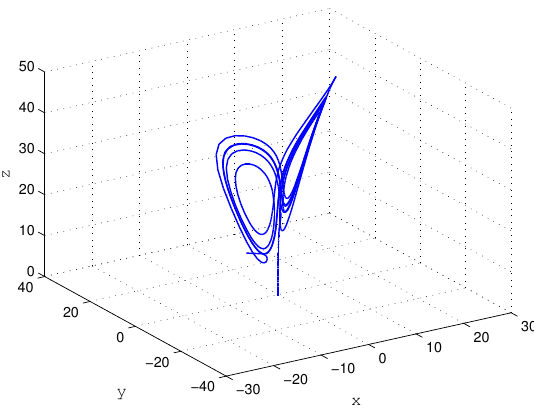
Figure 7. Phase portrait of the controlled uncertain system.